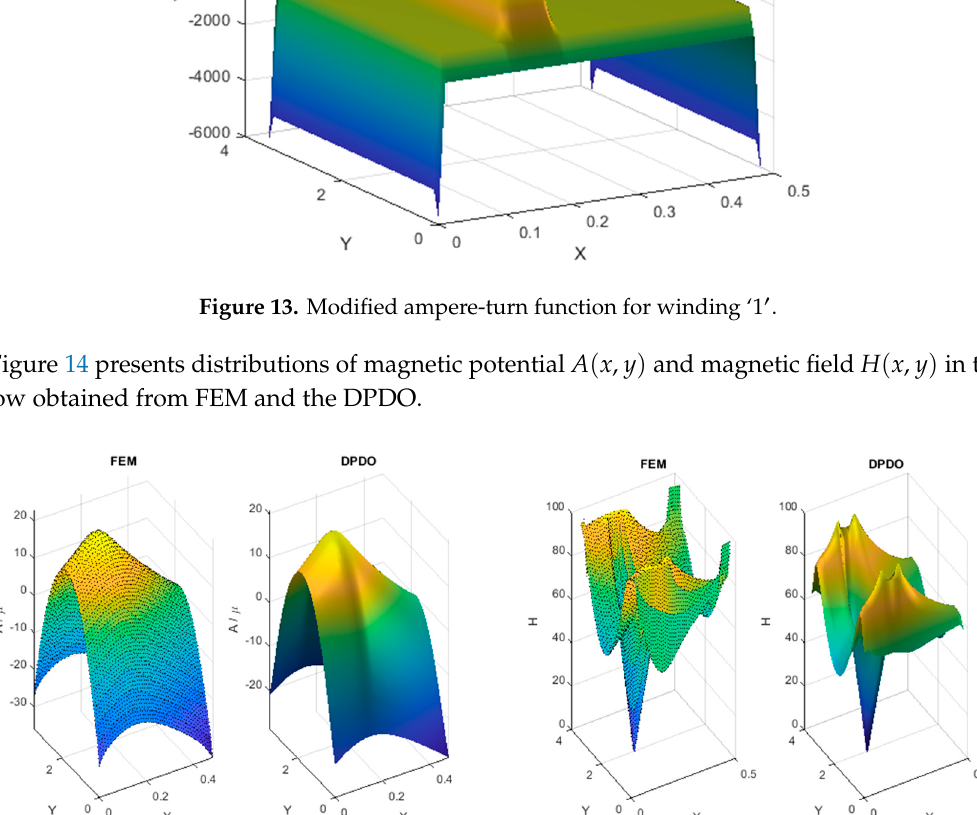
Figure 14. Distributions of magnetic potential ( , ) A x y and magnetic field ( , ) H x y in the air